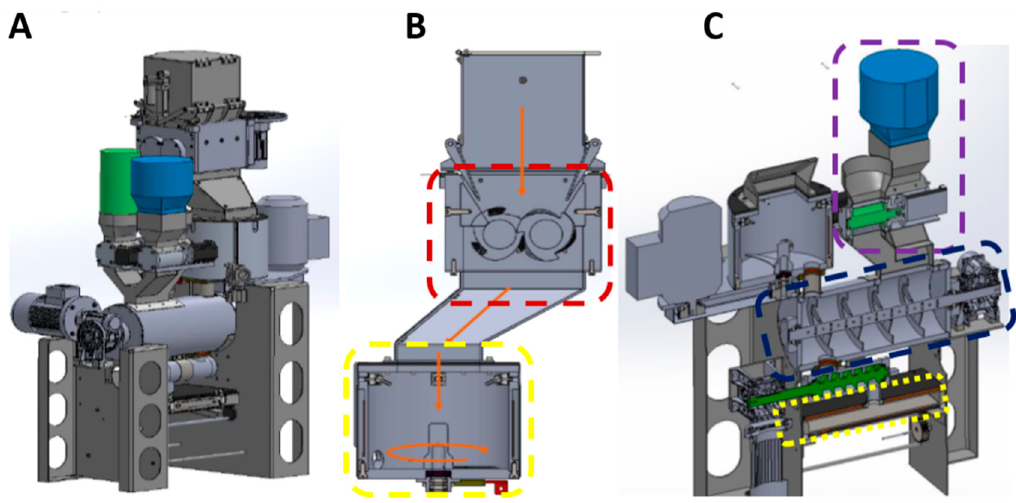
Figure 9. 3D pictures of the prototype machinery for OFMSW treatment: prospective view of the whole designed prototype (a), sectional view of the shredding system (b) and sectional view of whole prototype (c).